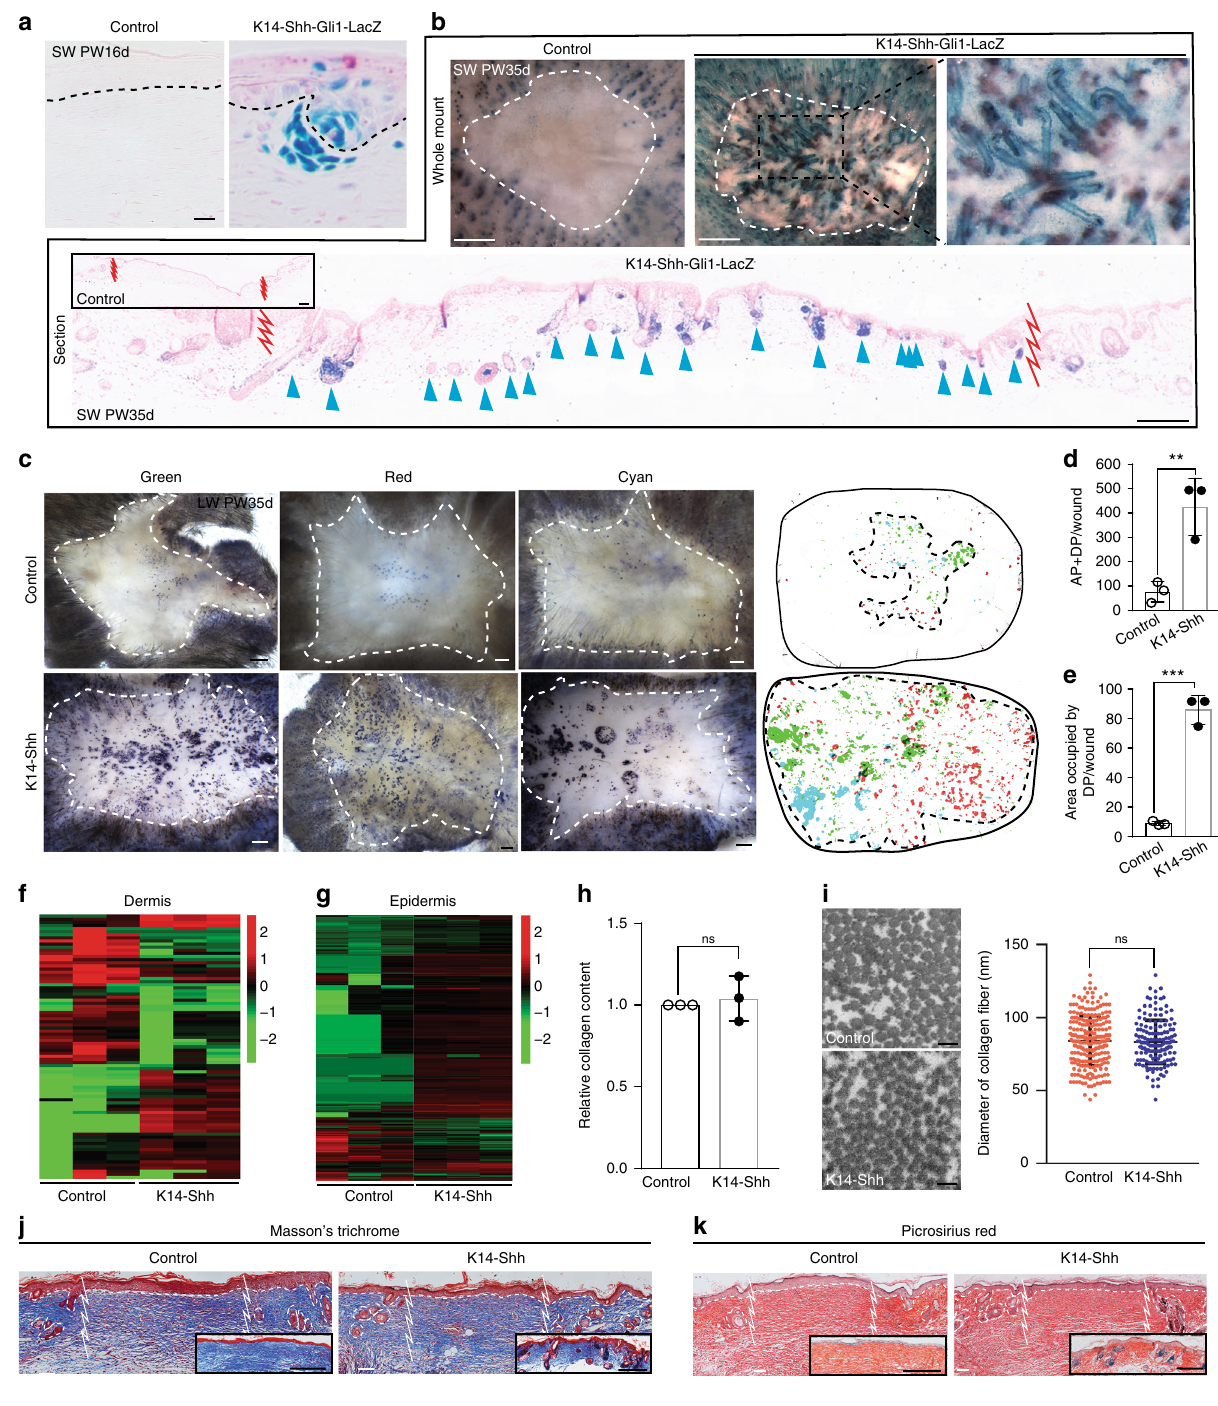
assessments for collagen staining (i.e., Masson trichrome and Picrosirius red staining) before and after the formation of neo- genic hair follicles (Fig. 2j, k). We found that the epithelial Shh expression and the reduction of type I collagen in the neighboring wound scar does not play a signi fi cant role in Shh-driven HF neogenesis. The data suggests that DP and hair follicles were forming within the scar of the wounds. Dermal Hh activation induces HF neogenesis in scarring wounds . To ask if direct Shh pathway activation of myo fi broblasts